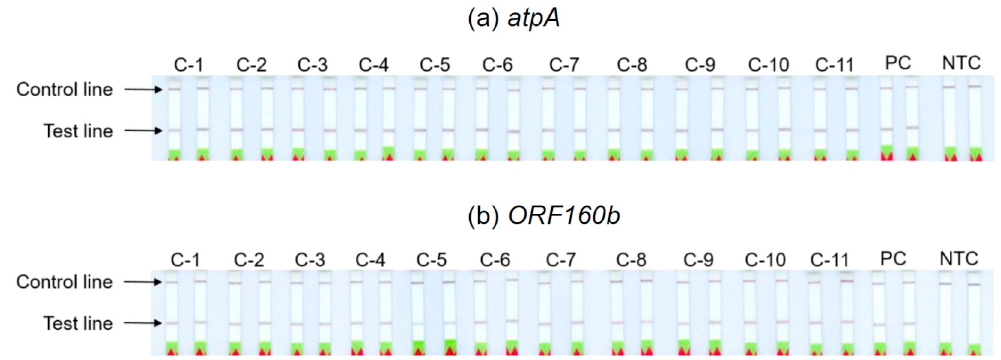
Figure 5. Screening of di ff erent soybean cultivars using ( a ) the atpA and ( b ) the ORF160b LAMP-LFD assays. Duplicate analysis of 1:10 5 diluted DNA (equivalent to 10 mg soybean per kg food) of the 11 soybean cultivars C-1 to C-11 according to Table 2 (PC: positive control yellow soybean (Schoenenberger ®® Hensel ®® ); NTC: no template controls).